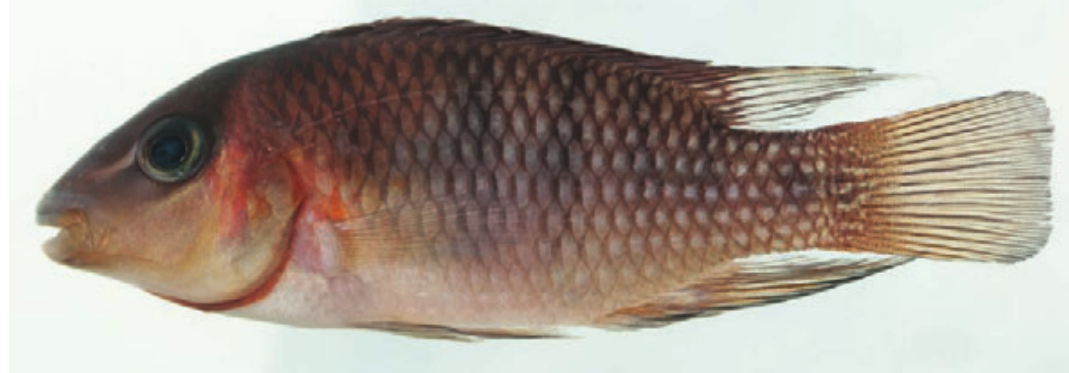
Fig. 10. Mazarunia charadrica , 65.0 mm SL, ROM 89553, live coloration in a specimen from the Kamarang River, photographed shortly after